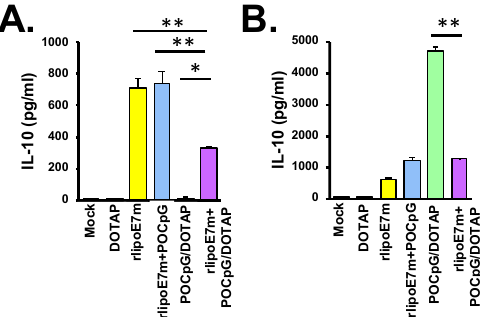
Figure 6. The combination of rlipoE7m and POCpG / DOTAP could decrease IL-10 production from dendritic cells (DCs). ( A ) cDC or ( B ) pDCs cultured from bone marrow-derived cells were incubated with the indicated lipoprotein and liposomal combinations for 24 h. IL-10 in supernatant collected from 1 × 10 6 cells / mL was determined by ELISA. These data were collected and analyzed from two independent experiments. (* p < 0.05; ** p <